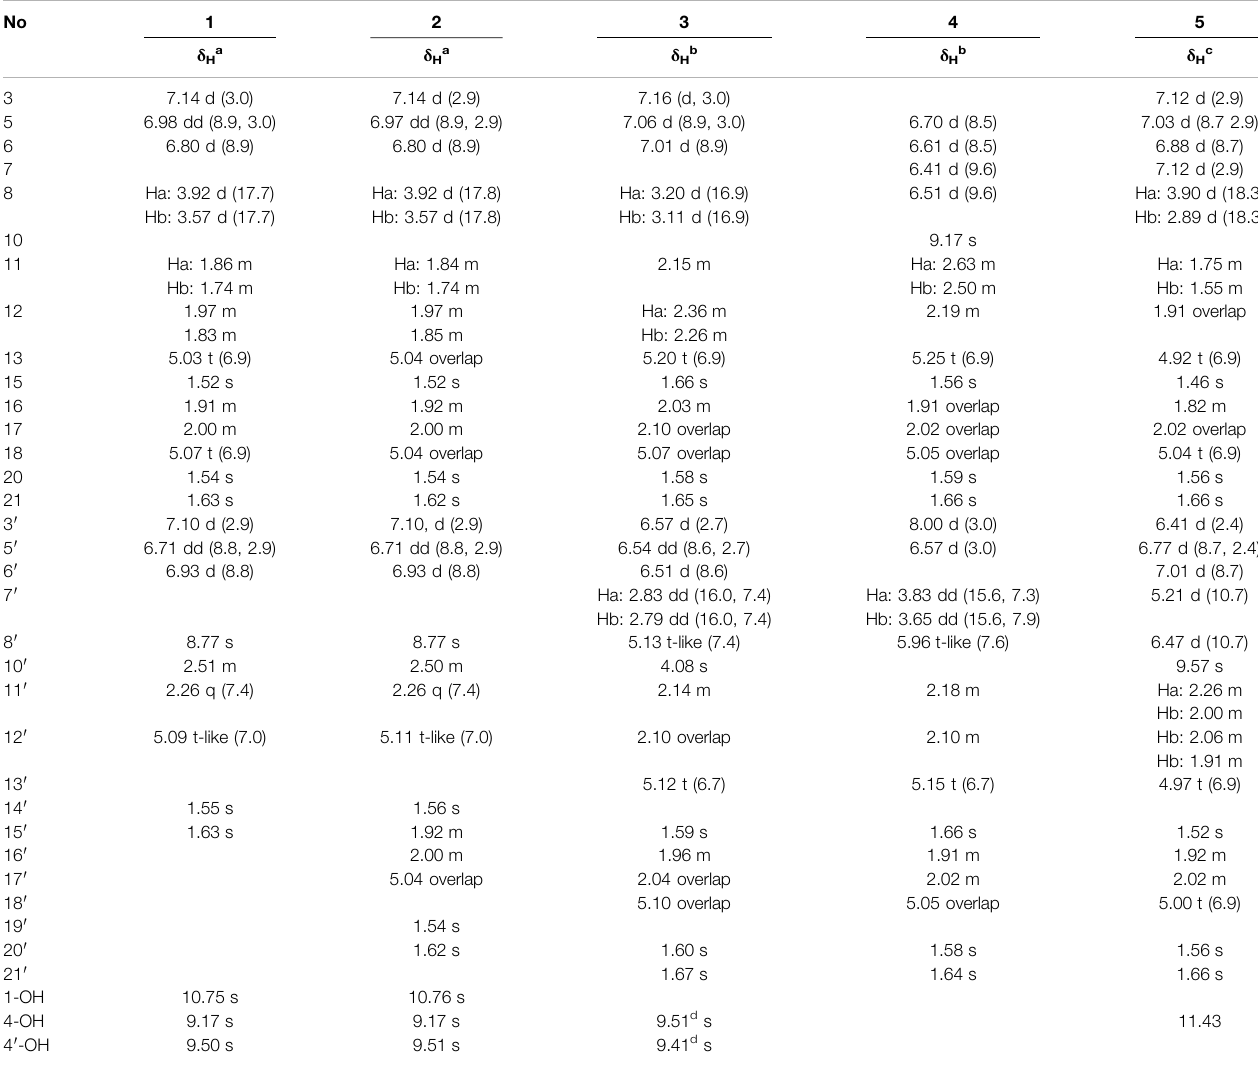
TABLE 1 | 1 H NMR data of 1 – 5 ( δ in ppm, J in